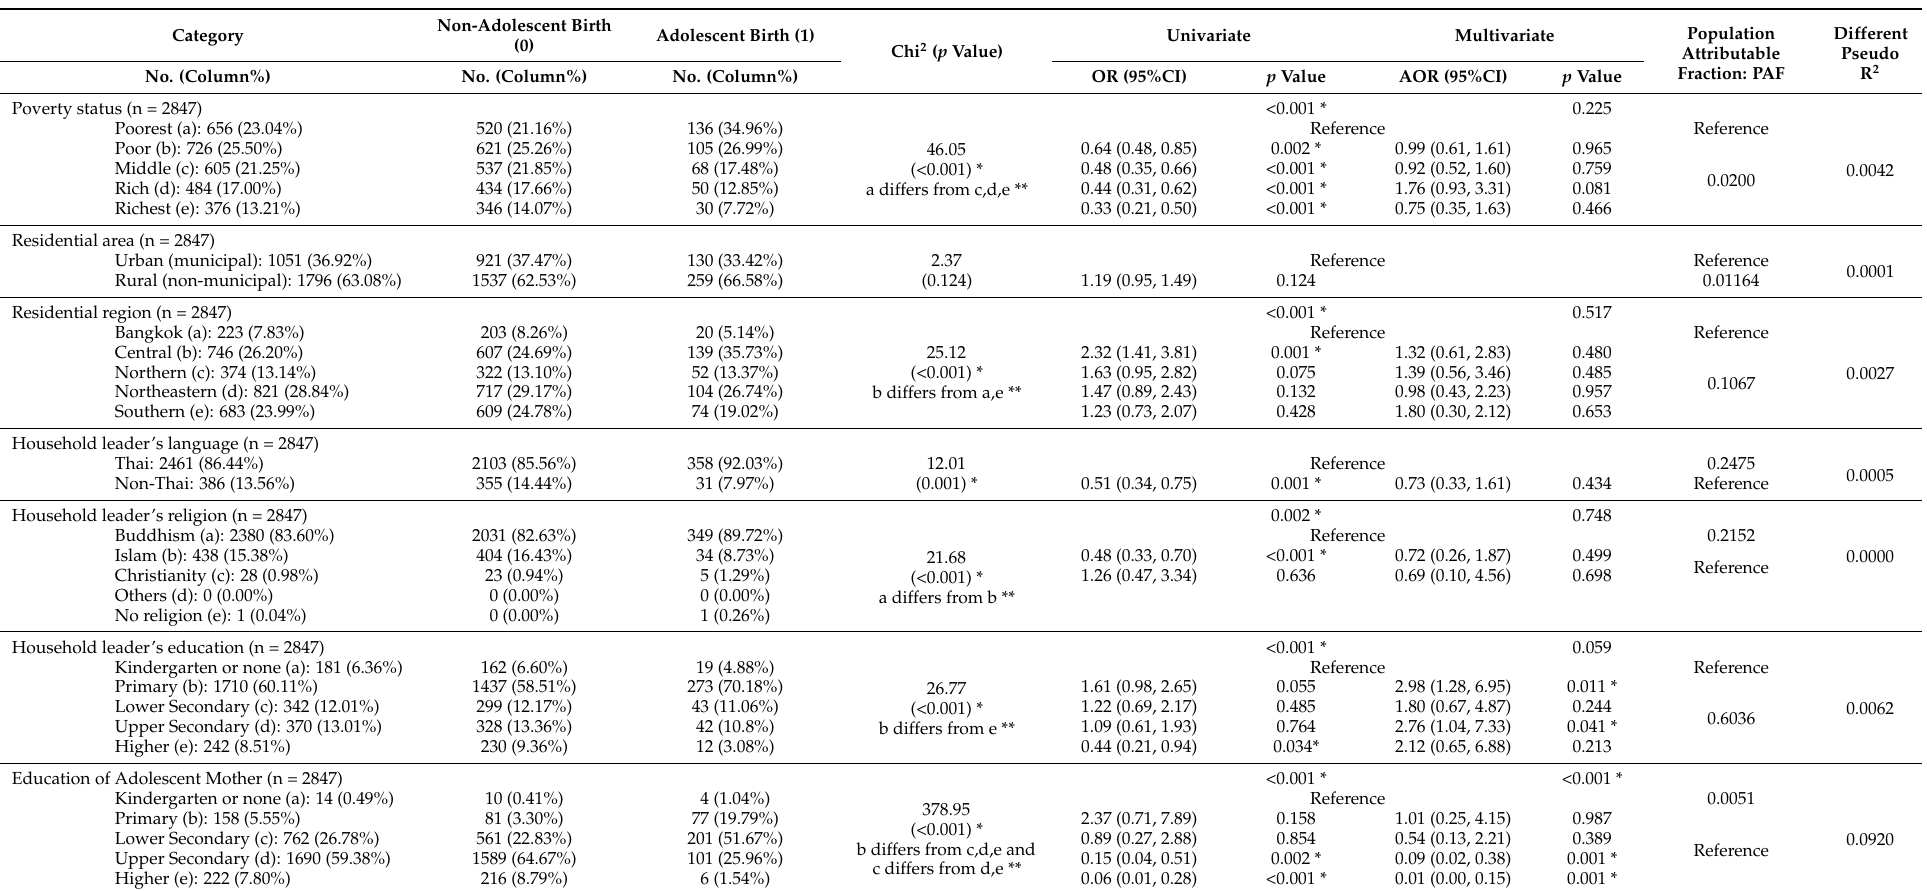
Table 4. The proportion of adolescent births by socioeconomic status (SES), association between adolescent birth and socioeconomic status, and effect of each SES as illustrated by the PAF and different pseudo-R-squared